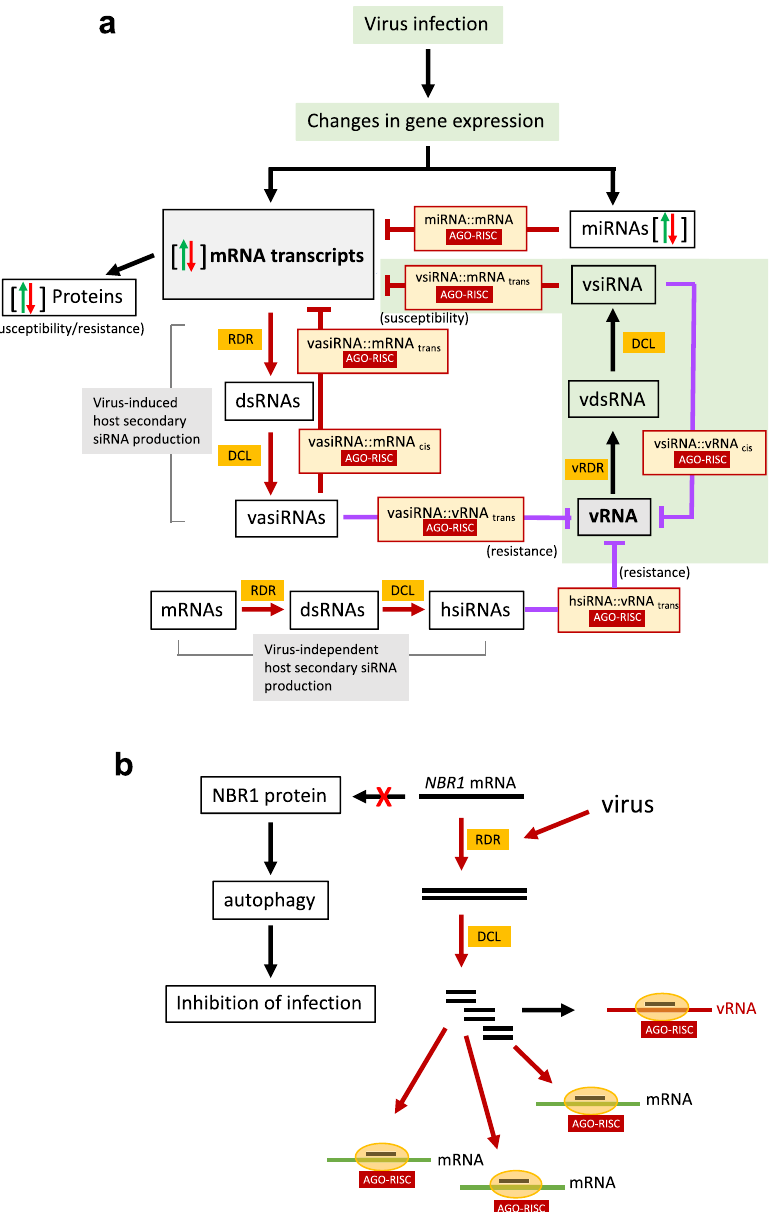
Fig. 7 Model of virus-host interactions mediated by sRNAs. a Virus infection induces a complex regulatory matrix of bidirectional sRNA-mediated interactions at the plant:virus interface. Virus infection causes changes in the expression of miRNAs and mRNAs that may be critical in the determination of host susceptibility and resistance. Perturbations in miRNA levels may affect the amplitude and ef fi cacy of miRNA-mediated cleavage resulting in changes in the level of their mRNA targets. Virus infection also triggers the biosynthesis of vasiRNAs from host transcripts via the formation of dsRNA intermediates. Recruitment of vasiRNAs into cleavage-effector silencing complexes provides control over a vast range of host transcripts including transcripts of the vasiRNA-producing genes and their homologs (e.g., vasiRNAs produced by CABBP1 ) and transcripts derived from secondary target genes (e.g., vasiRNAs produced by NBR1 ). The replicating virus uses dsRNA replicative intermediates to produce vsiRNAs which are competent to guide sequence-speci fi c cleavage of both viral and host-mRNA targets. Likewise, viral RNA is an accessible target for vsiRNA-, vasiRNAs, and hsiRNA-directed cleavage. hsiRNAs are produced by the host also in the absence of virus and may contribute to basal resistance of the host. b NBR1 may function as a regulatory hub for plant- virus interactions. The NBR1 protein controls virus infection by targeting viral effector proteins (e.g. the VSR of TuMV) and viral particles for degradation by autophagy. The virus, in turn, triggers conversion of NBR1 mRNA into vasiRNAs with the potential to induce widespread control over NBR1 and other gene targets. The role of NBR1 as a virus-inducible hub for trans -acting siRNA production is feedback-controlled through the ability of the same locus to also produce vasiRNAs that target the